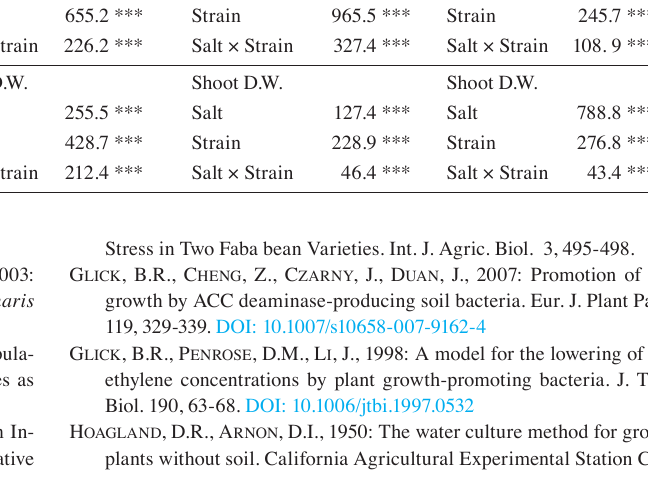
Fig. 2: Total dry weight of Ustica (UST), Castelluccio (CAST), Eston (EST), Masoor 85 (MAS) and Punjab (PUN) lentils, 16 days after the inoculation with 6, 6K and W10 strains in presence of different NaCl salinity concentrations (0, 4 and 8 dS m -1 ). Bars represent the mean ± SE. Different letters indicate significant differences (P ≤ 0.05) Tab. 4: Analysis of Variance of the effects of salinity and strains on shoot and root dry weight (D.W.) of Ustica (UST), Castelluccio (CAST), Eston (EST), Masoor 85 (MAS) and Punjab Masoor 2009 (PUN) lentils. UST CAST EST MAS PUN Root D.W.